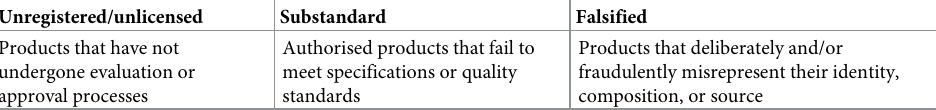
Table 2. Definitions of poor-quality drugs based on the international classification by WHO